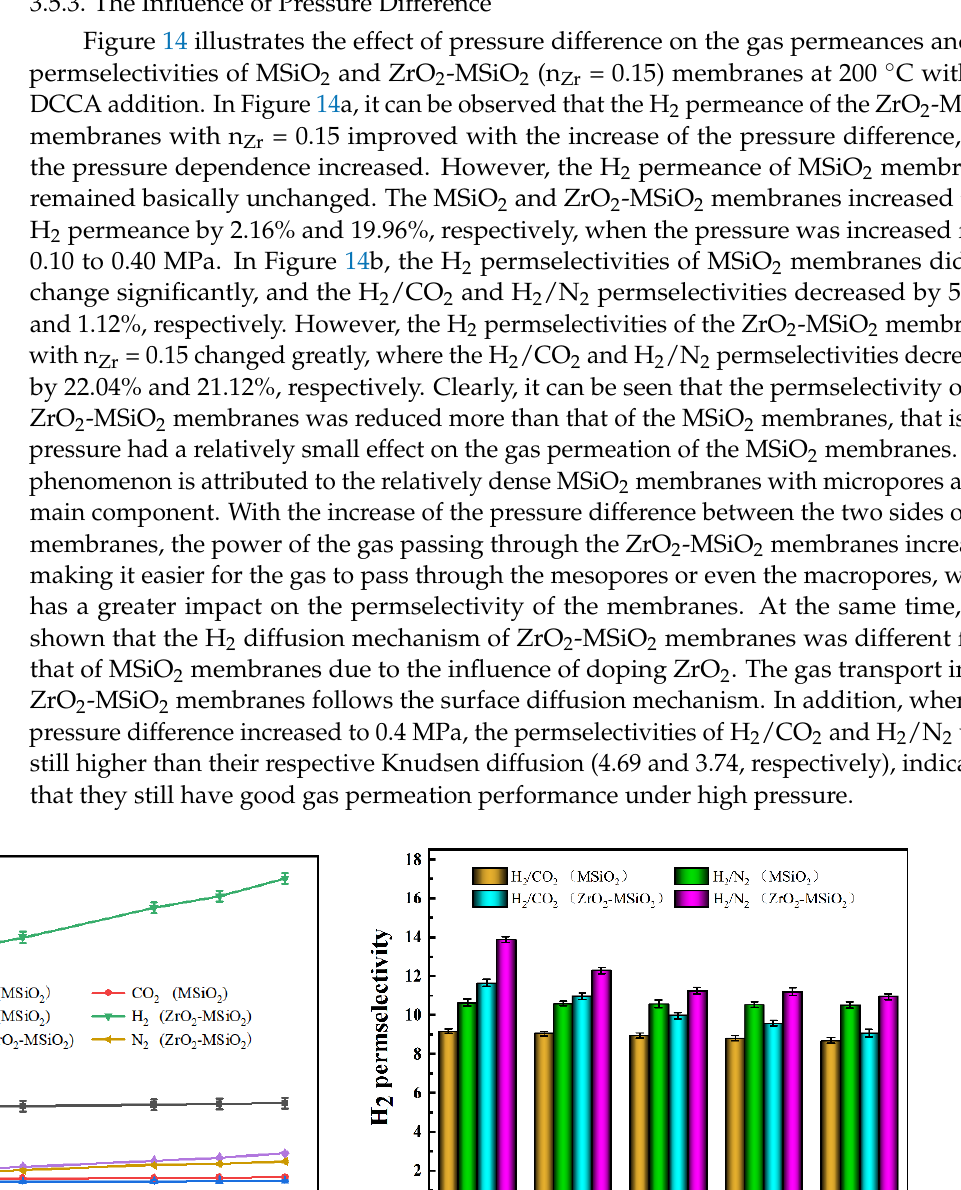
Figure 15. H 2 permeances and permselectivities of ZrO 2 -MSiO 2 membranes (n Zr = 0.15) with various DCCA additions at 200 °C and 0.1 MPa. Figure 15 demonstrates that the H 2 permeance of the ZrO 2 -MSiO 2 membranes re- duced by 21.30% as the DCCA addition increased from 0 to 30%. The permselectivities of H 2 /CO 2 and H 2 /N 2 increased by 21.77% and 14.07%, respectively. However, compared with the 20% membranes, the H 2 /CO 2 and H 2 /N 2 permselectivities of the membranes with the addition of 30% only increased by 2.14% and 0.28%, respectively. Figure 16 shows the relationship between DCCA (GL) contents and F H2 × α H2 (F H2 is the H 2 permeance, α H2 is the permselective of H 2 ). It was clearly observed that the addition of DCCA from 0 to 20% enhanced the F H2 × α H2 value, and after more than 20%, the F H2 × α H2 value showed a lower